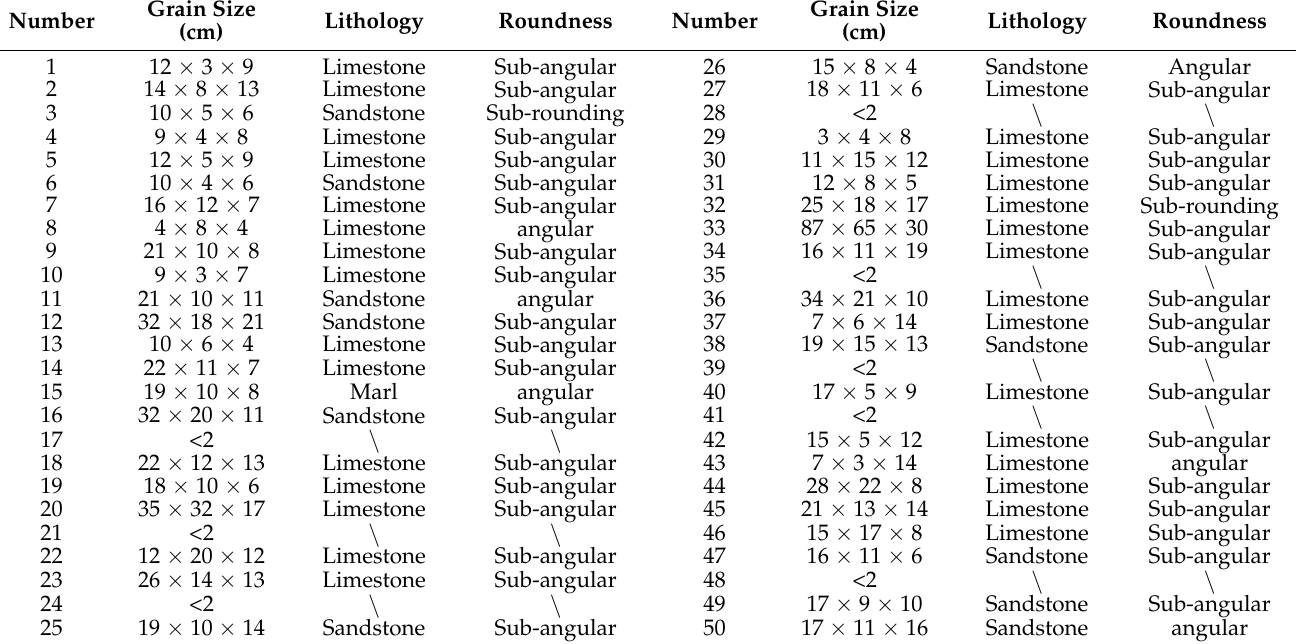
Table 3. Investigation of particles in the deposit fan of Yapi